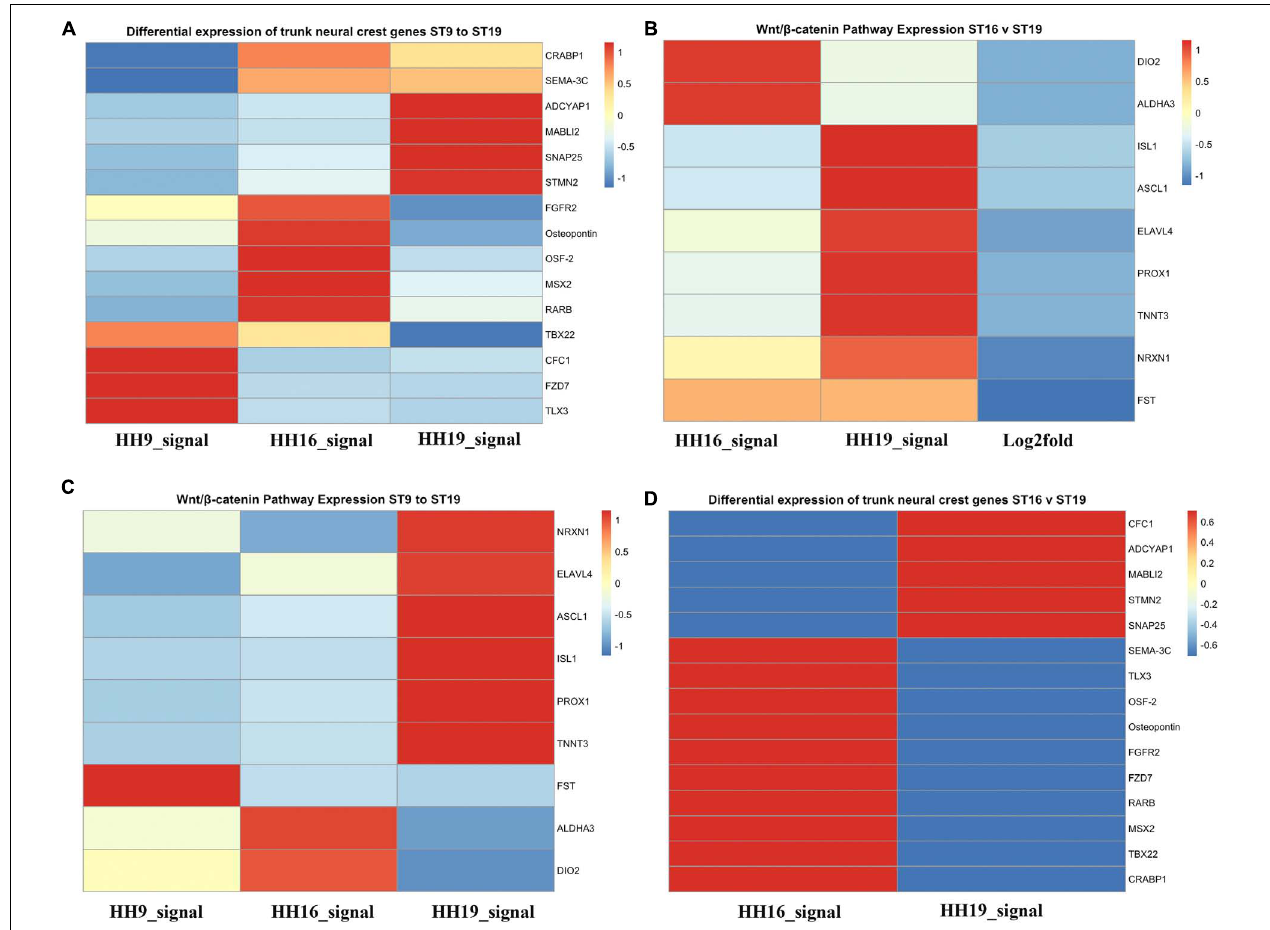
FIGURE 7 | Heatmaps for HH9, HH16 and HH19 macroarray. (A) Heat maps based on macroarray signal intensities for significant genes were generated in pheatmap 1.0.12 run in R 3.5.2 (Kolde and Vilo, 2015; R Core Team, 2018). (A) Differential expression of trunk NCC genes HH9, HH16 and HH19. (B) WNT/ β -catenin pathway expression of HH16 versus HH19. (C) WNT/b-catenin pathway expression of HH9, HH16, and HH19 comparison. (D) Differential expression of trunk NCC genes HH16 versus HH19. Heatmap color scale follows the sequential scales, blended progression, from the least (blue) to the most (red) shades, representing low to high values (blue to red scale, with white as almost no